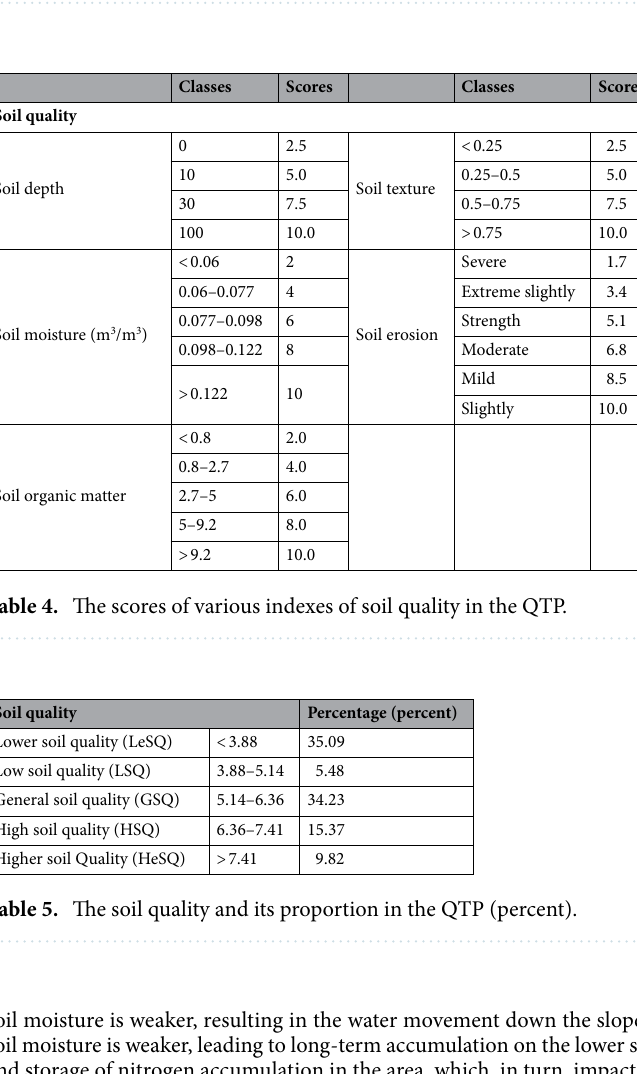
Table 3. The climate quality and proportion of the QTP.